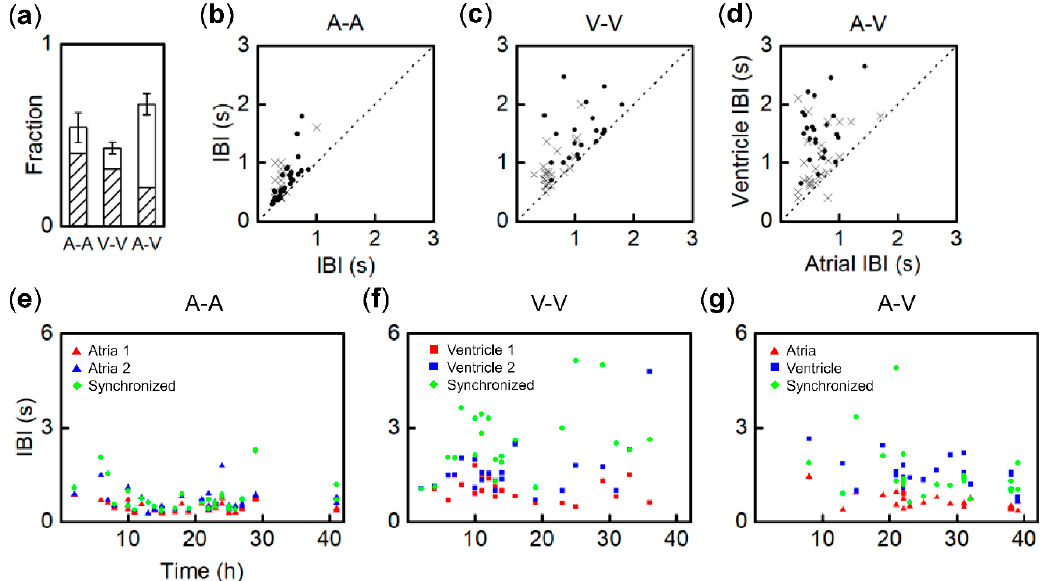
Figure 3. Statistics of synchronization for tissue fragment pairs of A–A, V–V, and A–V. ( a ) Synchronization probability in which the fraction attained 1:1 (diagonal line area). ( b – d ) Two IBI values at t = 1 h vs. 1:1 synchronization for A–A, V–V, and A–V, respectively. Circles and crosses represent synchronized and nonsynchronized pairs, respectively. For ( b ) and ( c ), faster IBI is plotted as x. For ( d ), atrial IBI is plotted as x. ( e – g ) 1:1 synchronization time vs. IBI at t = 1 h for A–A, V–V, and A–V (triangle, square), respectively. Synchronized IBI is displayed as green rhombuses. Red marks represent faster IBI at t = 1 h, and blue marks represent slower IBI.